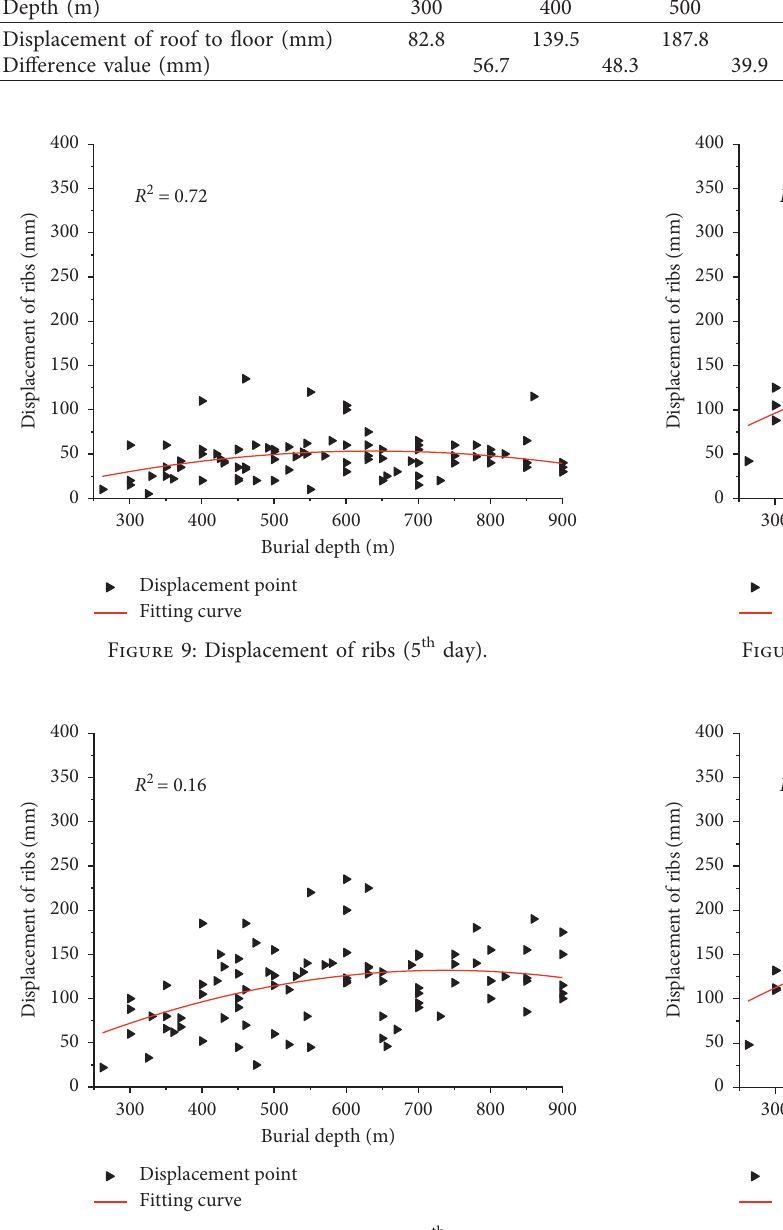
Figure 10: Displacement of ribs (15 th day).